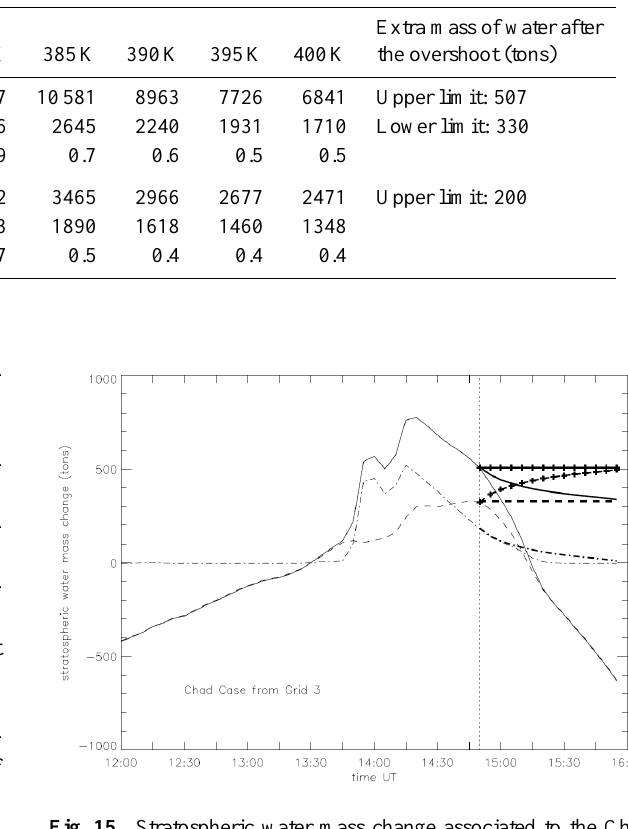
Table 3. Water budget associated to the overshooting convection for the Chad and the A¨ır cases across different isentropic surfaces. The integrated flux is the total mass of water crossing the θ levels upward during the integration period covering the overshoot (4h for the Chad case and 1h 50min for the A¨ır case). Also shown are the same results divided by the period of integration. The lower limit and the upper limit of the mass of water injected by the overshoot which remains in the stratosphere after the ice disappears are given for each case.